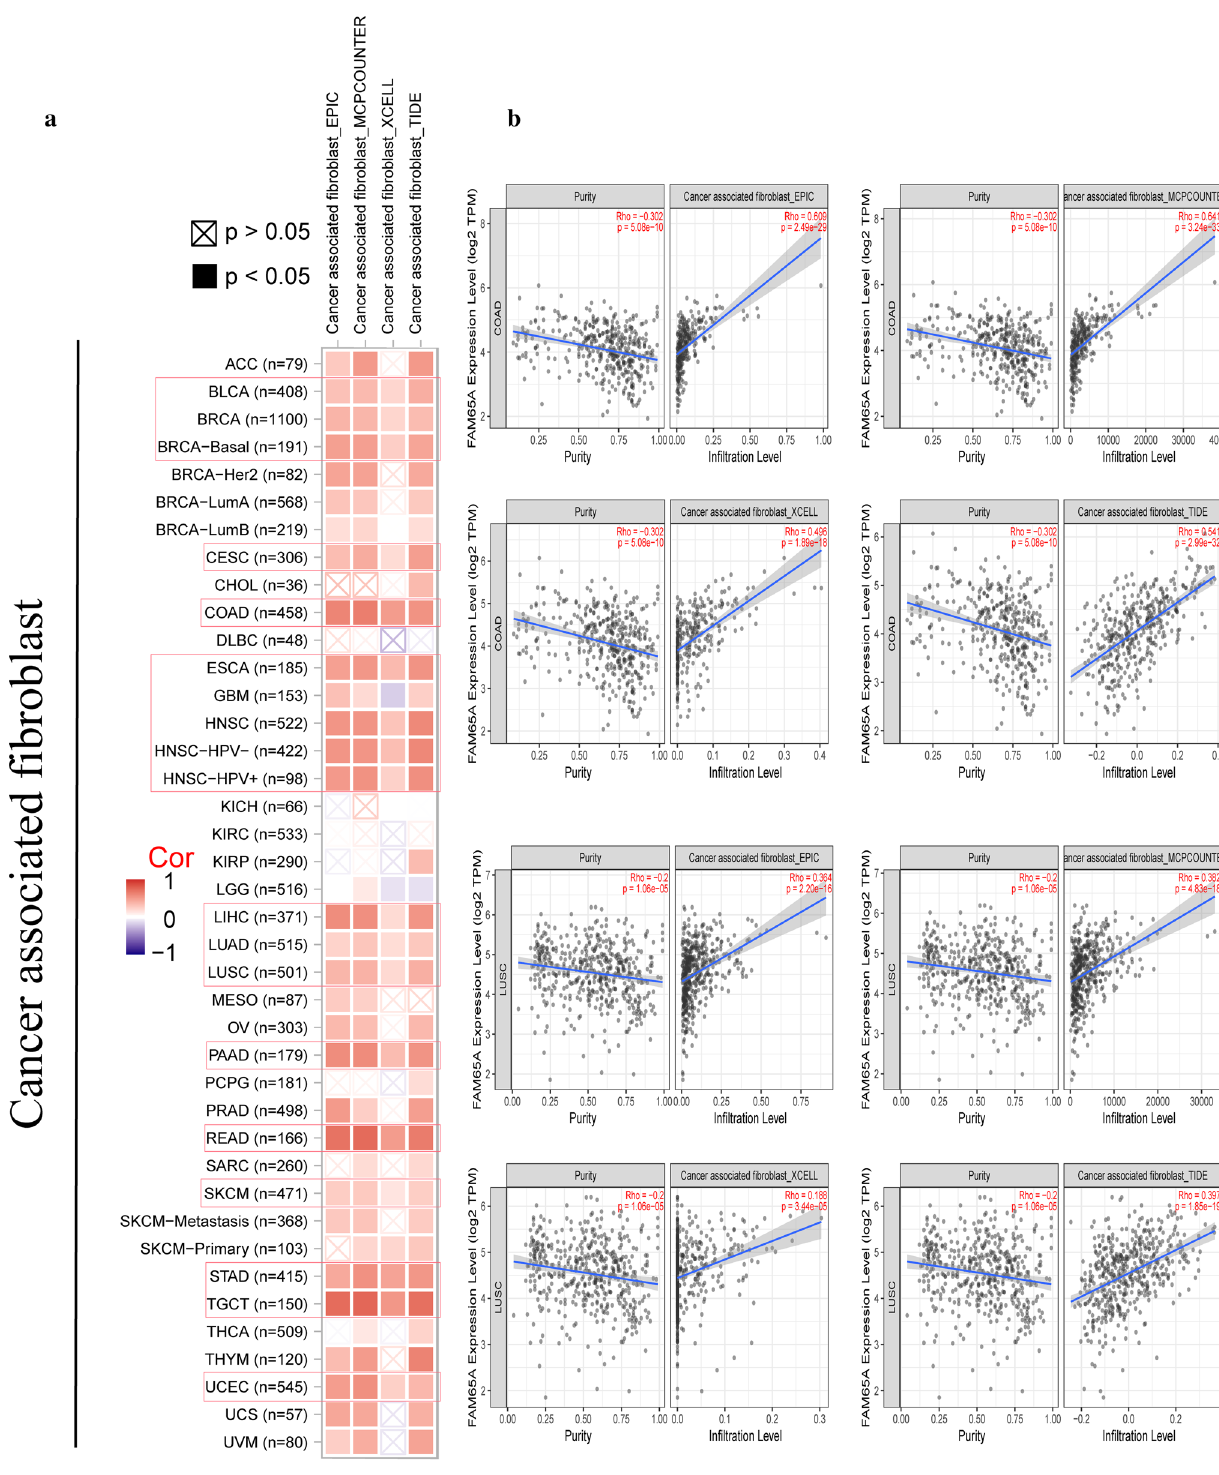
Fig. 5 Correlation analysis between FAM65A expression and immune infiltration. a The correlation between FAM65A expression and the immune infiltration of CAFs in different tumors is presented based on EPIC, MCPCOUNTED, XCELL and TIDE algorithms. b The scatter plot data of COAD and LUSC are